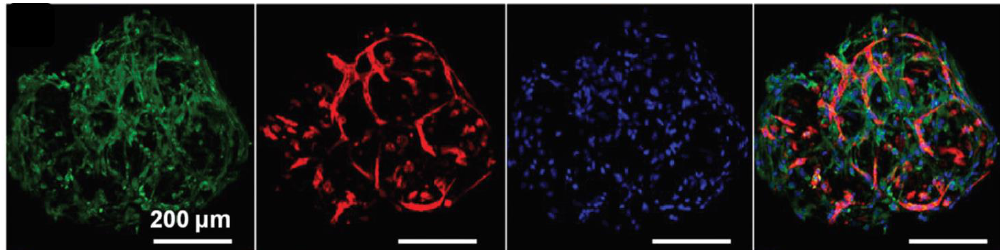
Figure 8. Co-culture of NHLFs (green) and endothelial cells (red) are co-localized (blue staining of nuclei) within collagen-fibrin microbeads. Reproduced with permission from [127]. Copyright The Royal Society of Chemistry 2014.